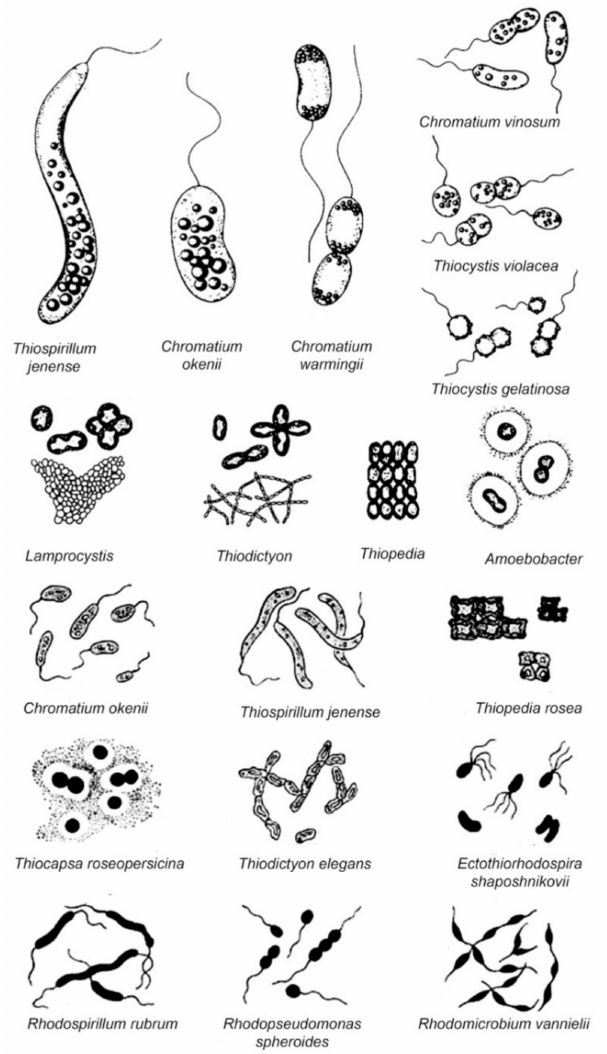
Figure 2. The morphological diversity of some phototrophic purple bacteria